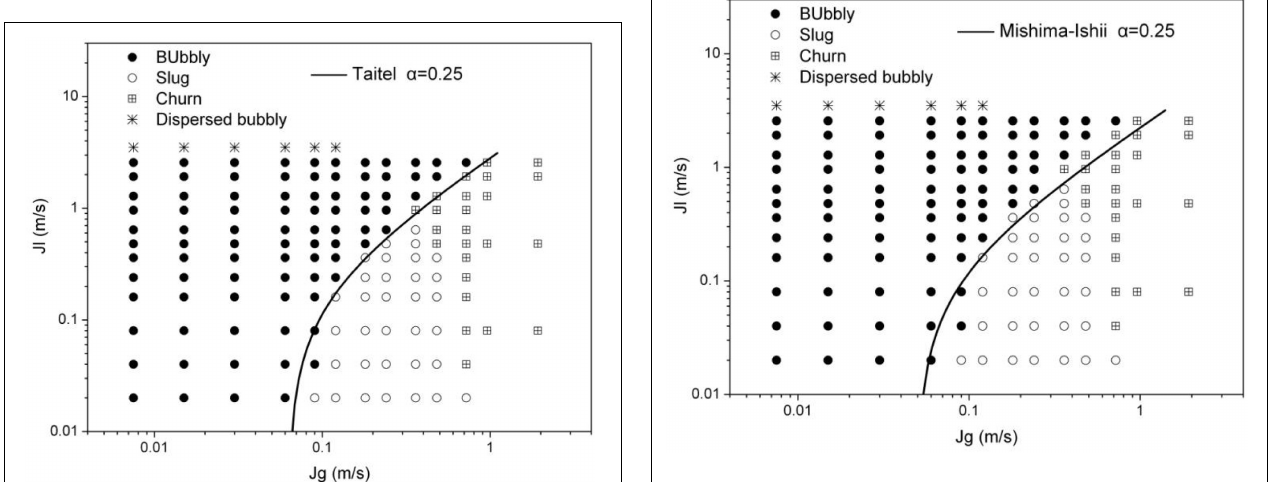
FIGURE 11 | Comparison between modified Mishima-Ishii criterion and experimental